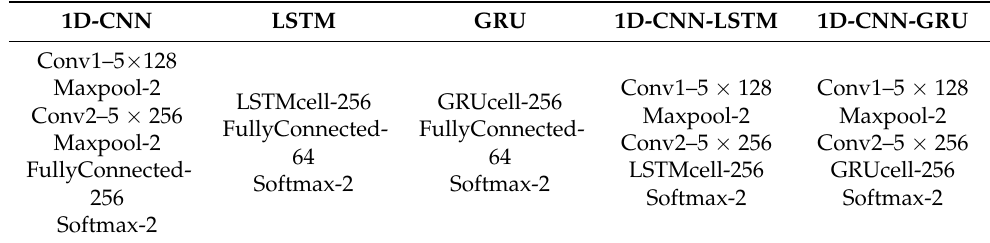
Table 7. Parameters of comparison models.